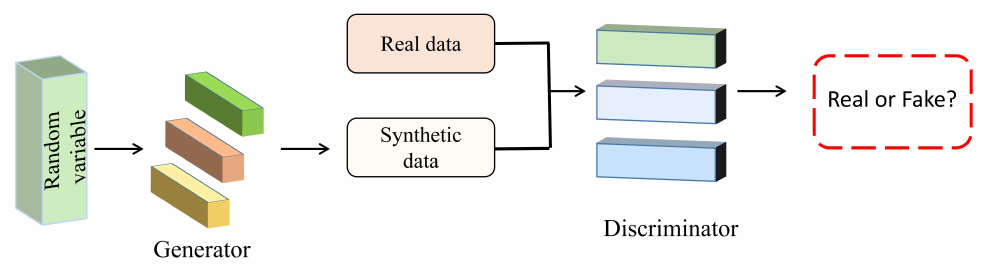
Figure 8. GAN architecture simulation diagram.